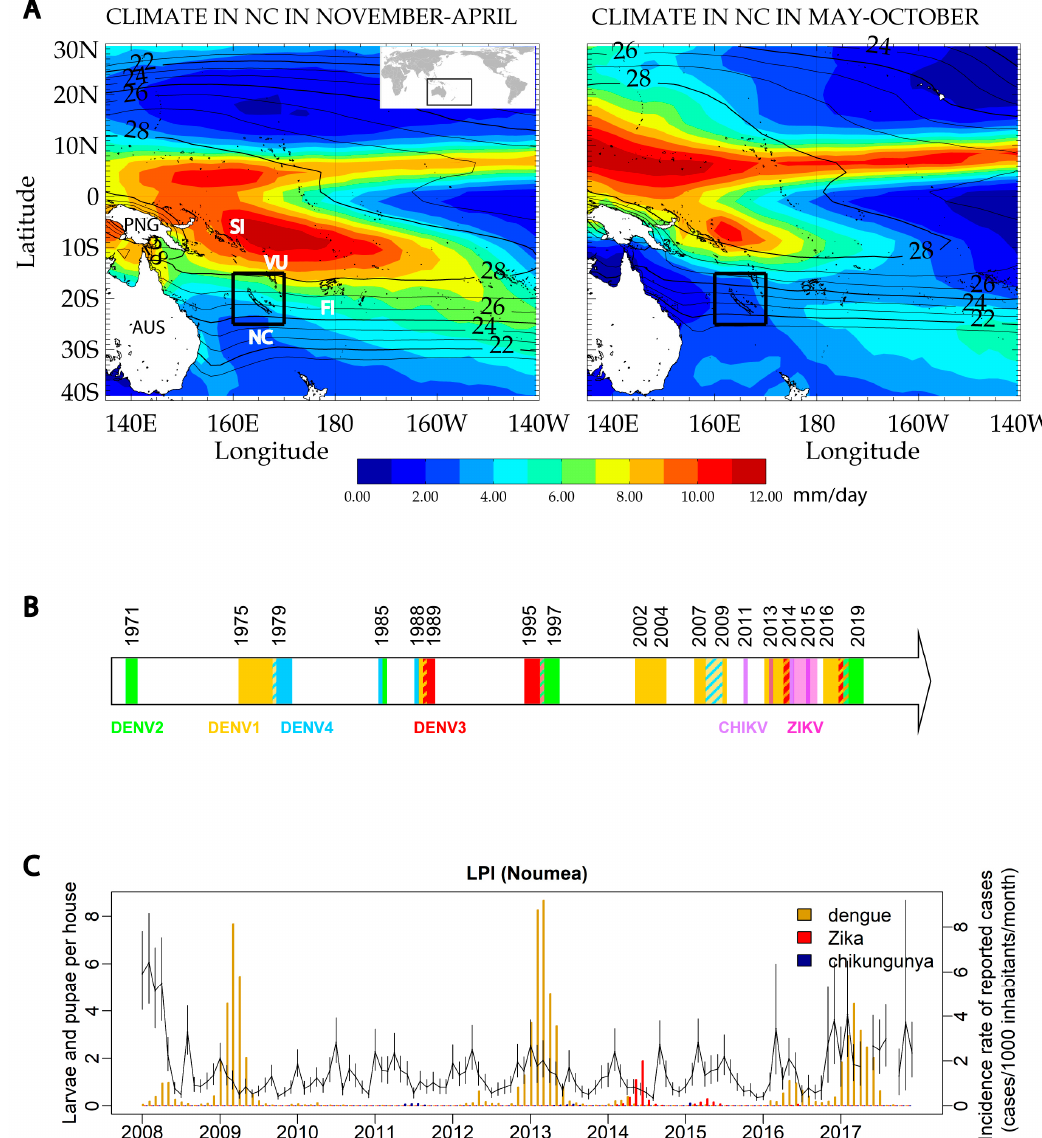
Figure 1. Temperatures, precipitations and history of arbovirus circulation and vector densities in New Caledonia, South Pacific region. ( A ) Summertime and wintertime maps of precipitation (rainbow scale, mm / day) with contours of air temperature ( ◦ C). PNG: Papua-New Guinea, AUS: Australia, SI: Solomon Islands; FI: Fiji, NC: New Caledonia. ( B ) Timeline of arboviruses circulation in New Caledonia between 1971 and 2018 (Source Institut Pasteur in New Caledonia, generated based on the data published by the Health Authorities (https: // dass.gouv.nc / votre-sante / documents-rapports-etudes)). ( C ) Graphical representation of the monthly average numbers of larvae and pupae per house in Noumea between 2008 and 2018. Error bars indicate the 95% confidence intervals. Incidence rates expressed as the number of cases per 1000 inhabitants per month are indicated for dengue, Zika and chikungunya (http: // www.institutpasteur.nc / wp-content / uploads / 2016 / 12 /